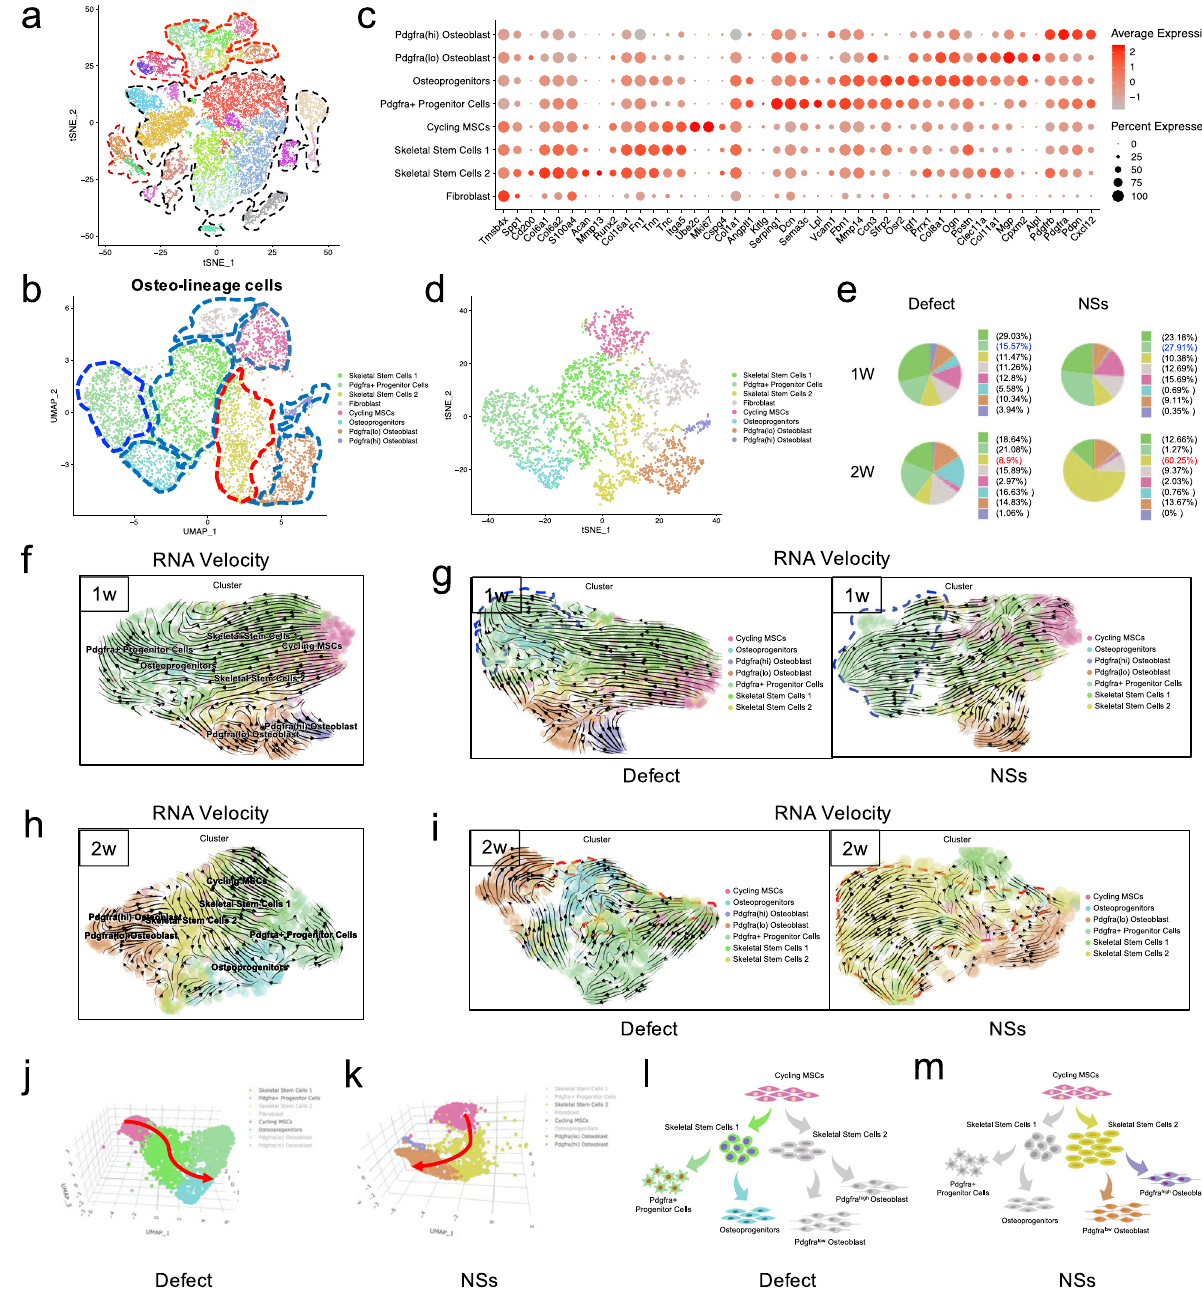
Fig. 4 | NSs differentially regulated skeletal stem/progenitor cells for osteo- genesis.a tSNEplotshowsthedistributionof26016cellsandhighlightingofosteo- lineage cells (red dotted line). b Visualization of osteo-lineage cells highlighted in a with UMAP plot, which was divided into eight sub-clusters. c Dot plots showing the expression of marker genes in the eight osteo-lineage sub-clusters. Dot size represented the proportion of cells expressing speci fi c gene in the indicated sub- sets and color bar represented the gene expression levels. d tSNE plot shows the